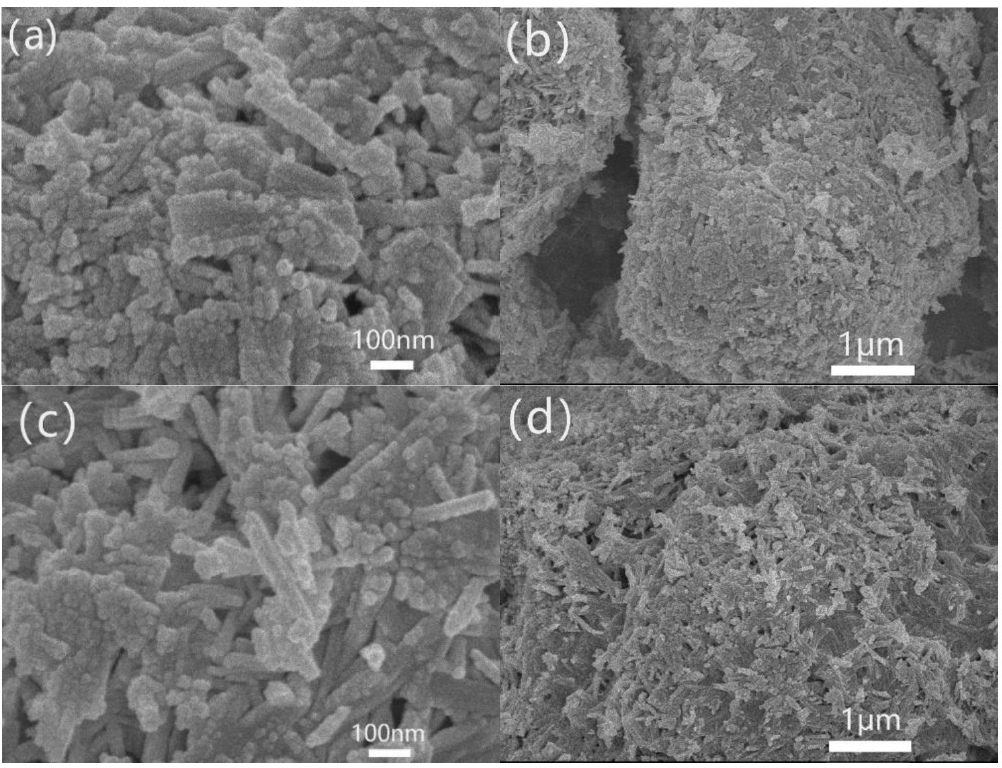
synthesized at 160 °C, 36 h and 0.03 mol/L citric 3